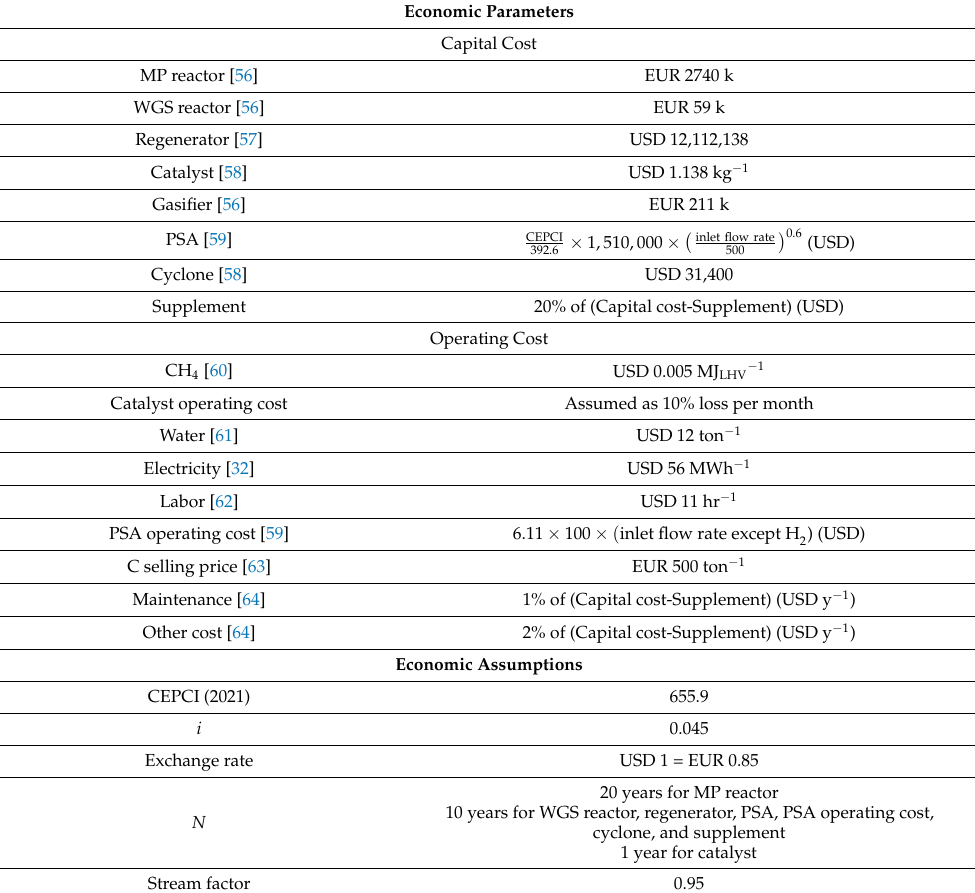
Table 2. List of economic parameters and assumptions used in itemized cost